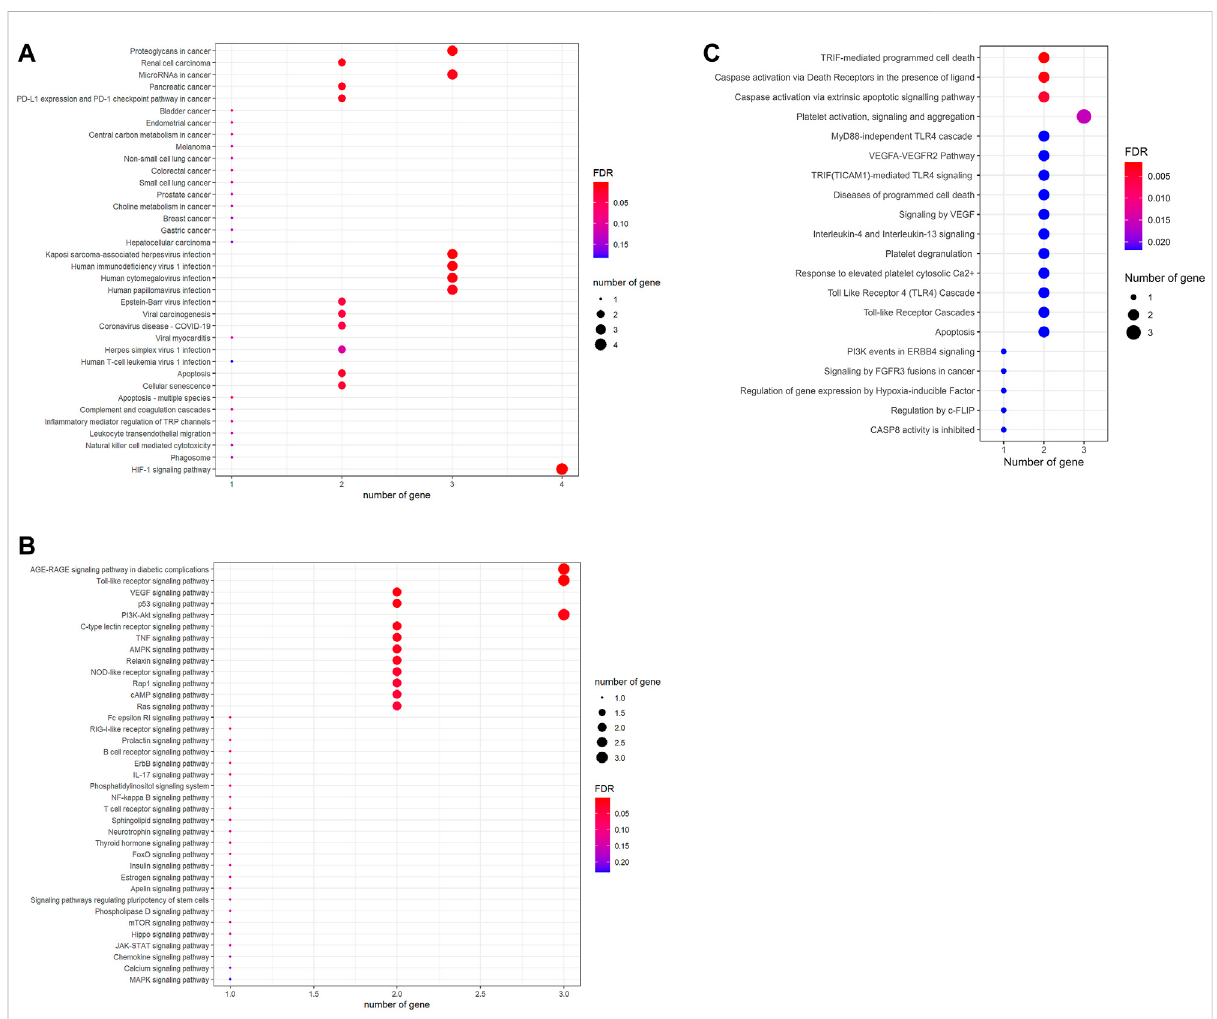
FIGURE 3 Laminarin ’ stargetsinvolvedinpathways related tocancer andcell apoptosis. Kyoto EncyclopediaofGenesand Genomespathway enrichment analysis highlighted the involvement of laminarin ’ s targets in (A) cancer, viral infection, cell death, and immune responses; and (B) cell signaling pathways related to cancer development. (C) Reactome pathway analysis highlighted the importance of laminarin in cell apoptosis. The size of a bubble represents the number of genes, and the color of the bubble represents the signi fi cance of the